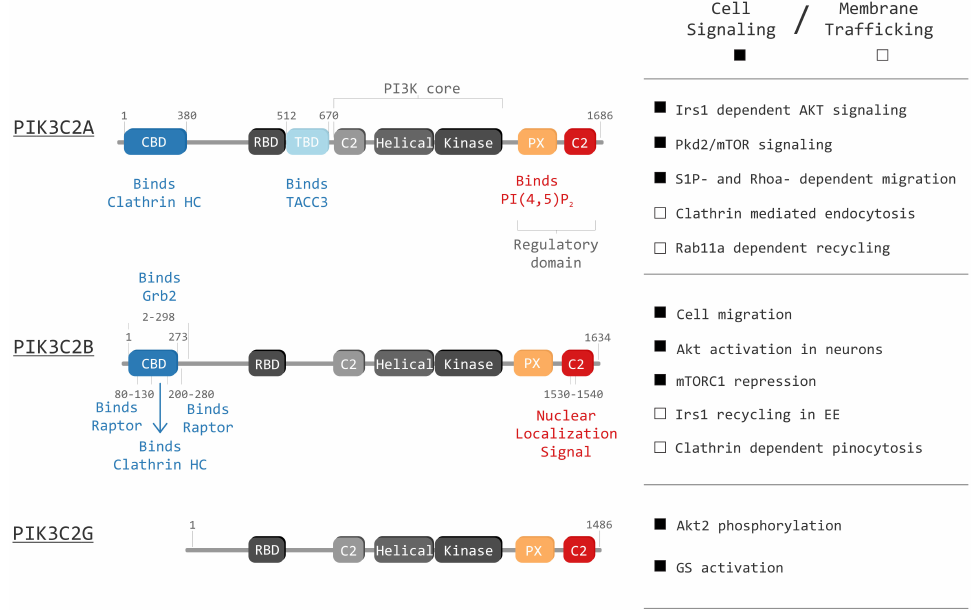
Figure 1. Graphical representation of class II phosphoinositide 3-kinases (PI3Ks) in mammals (PIK3C2A, PIK3C2B and PIK3C2G) and their domains: Clathrin binding domain (CBD), Ras binding domain (RBD), TACC3 binding domain (TBD), C2 membrane interacting domain (C2), Helical domain (Helical), Kinase domain (Kinase) and Phox homology domain (PX). The right panel displays known functions of each isoform. The right panel highlight principal cell signaling (black squares) and membrane trafficking (white squares) roles of the three